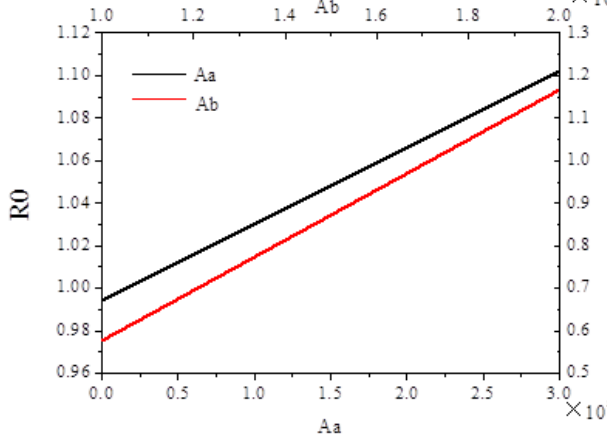
Figure 3. The effect of the birth number of wild (A a ) and domestic dogs (A b ) on the R0.